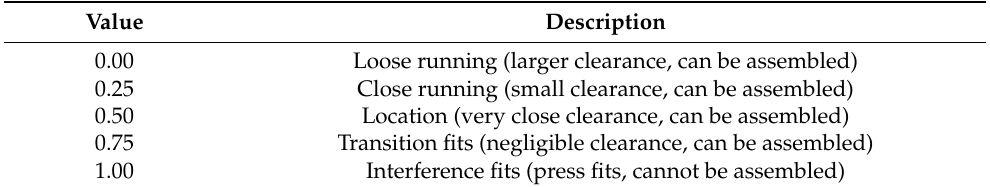
Table 1. Values and Description of the Assumed Plug-Gauge Fitting Scale (according to